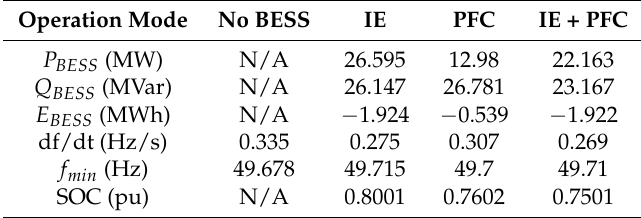
Figure 14. The frequency (pu) oscillation of generators with a single-phase-to-ground fault. Table 3. The frequency results of G1 with a single-phase-to-ground fault.